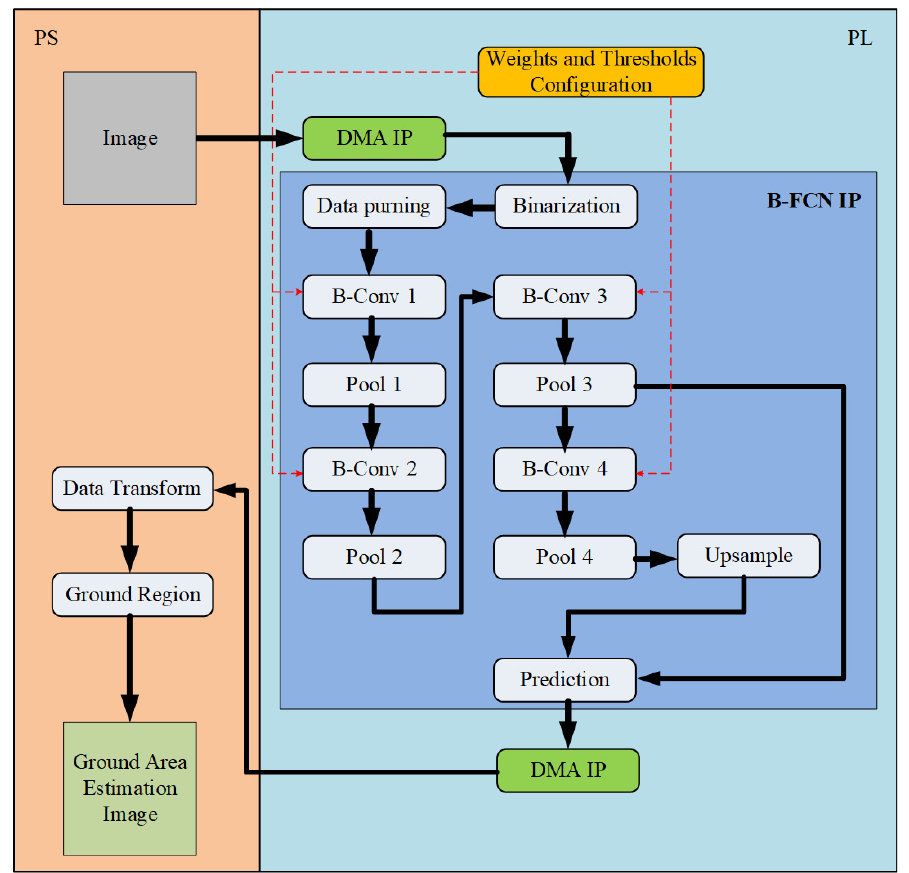
Figure 7. The proposed B-FCN system architecture on PYNQ ZCU104 FPGA.